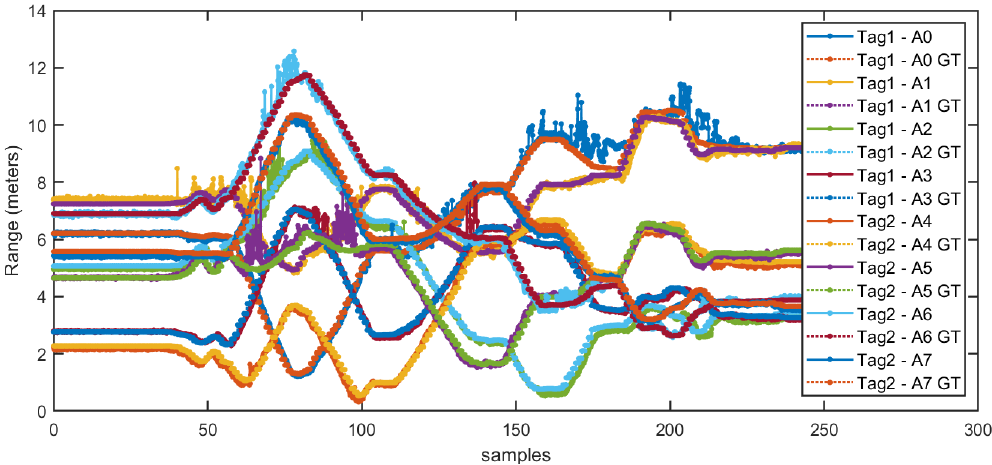
Figure 12. Range estimations between different anchor to tag vs. the GT (ground-truth) range. The range error distributions, for the same dynamic case of moving one pair of tags (as in Figure 12), can be seen in Figure 13.